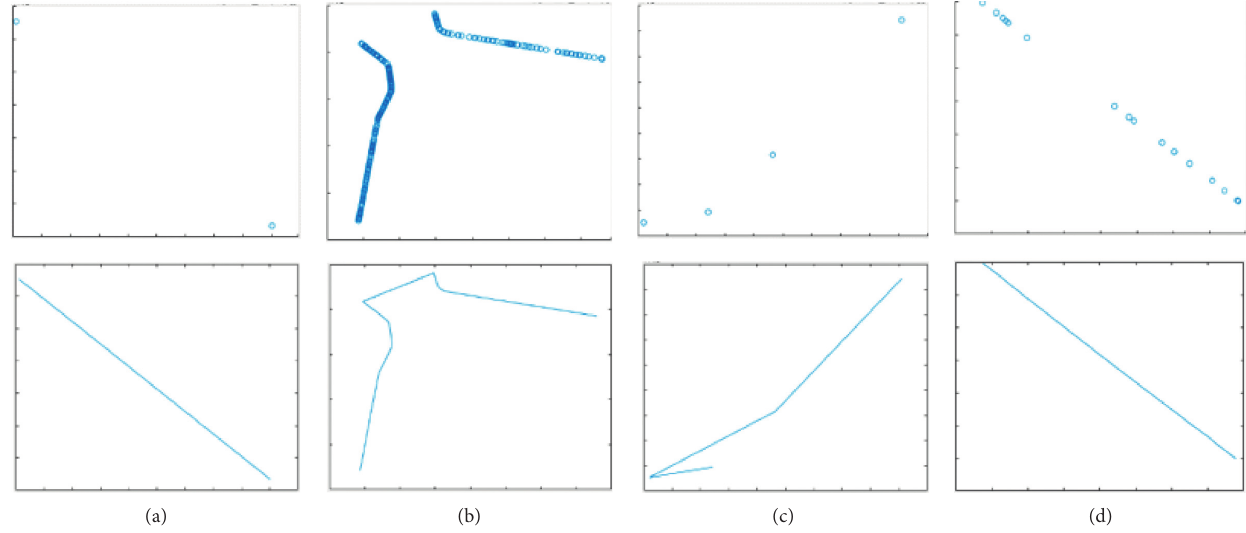
Figure 2: Scatter diagram and trajectory diagram corresponding to wrong trajectory. (a) Scattered trajectory. (b) Multiconnected trajectory. (c) Misplaced trajectory. (d) Defective